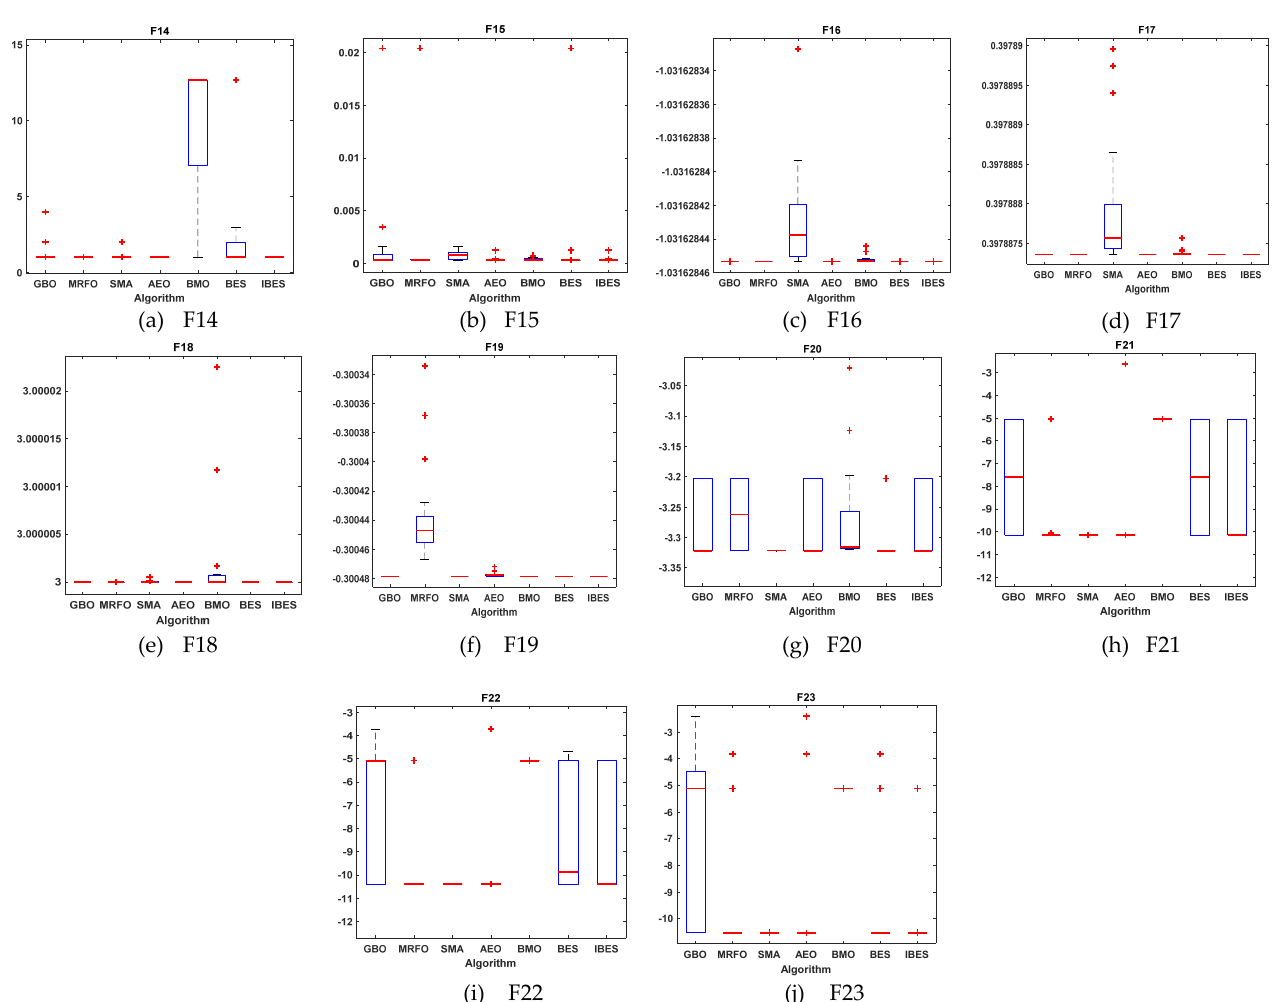
Figure 11. Boxplots for all algorithms for multimodal benchmark functions ( a ) F8, ( b ) F10, ( c ) F12, and ( d ) F13.